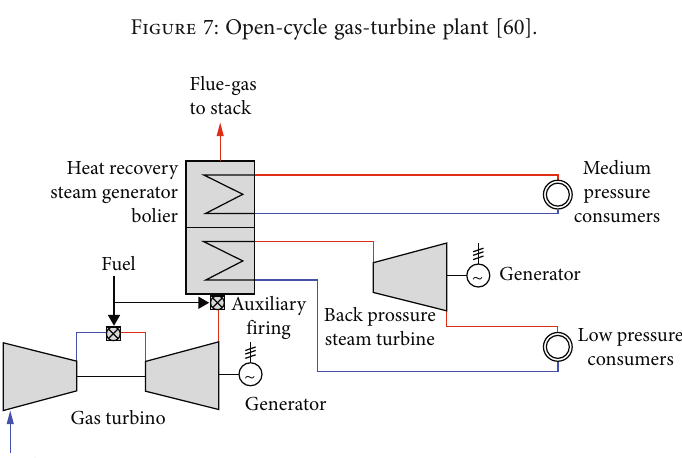
Figure 7: Open-cycle gas-turbine plant